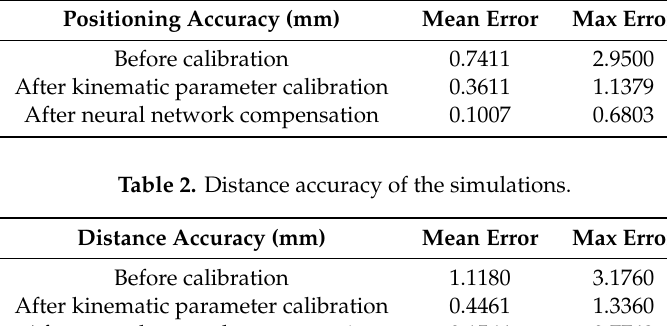
Figure 9. Distance accuracy of the simulations.